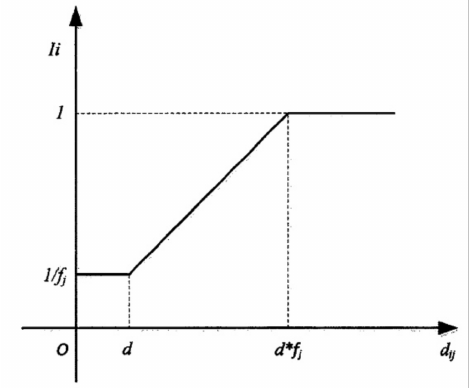
Figure 8. Relationship diagram of suppression factor and nodes distance. Ii is the size of the suppression factor, t j is the search failure node, f j is the number of search failures of t j , d ij is the distance between any node t i and node t j results in search